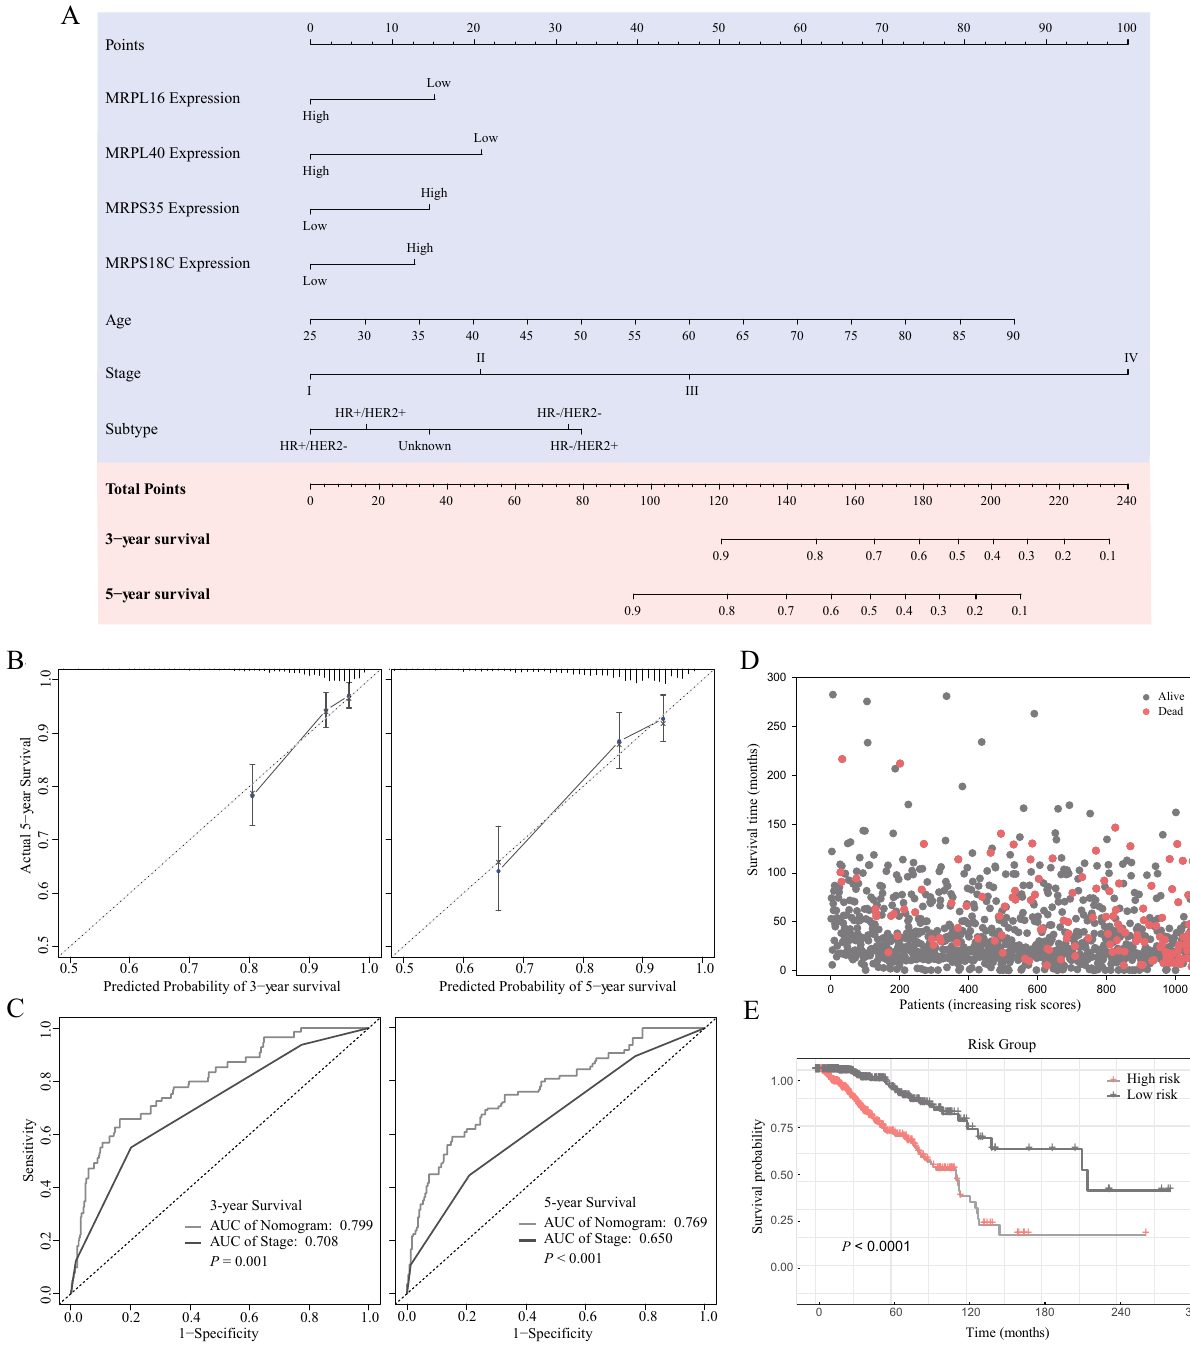
Figure 6. MRP-based prognostic model and its evaluation. ( A ) A nomogram to predict the overall survival in BC patients. ( B ) Calibration curves of the nomogram to predict the probability of 3-year and 5-year overall survival. ( C ) Time-dependent receiver operating characteristic curves for nomogram-based 3-year and 5-year overall survival prediction. ( D ) Patient distribution based on different risk scores. ( E ) Kaplan–Meier survival curves of different risk groups in BC